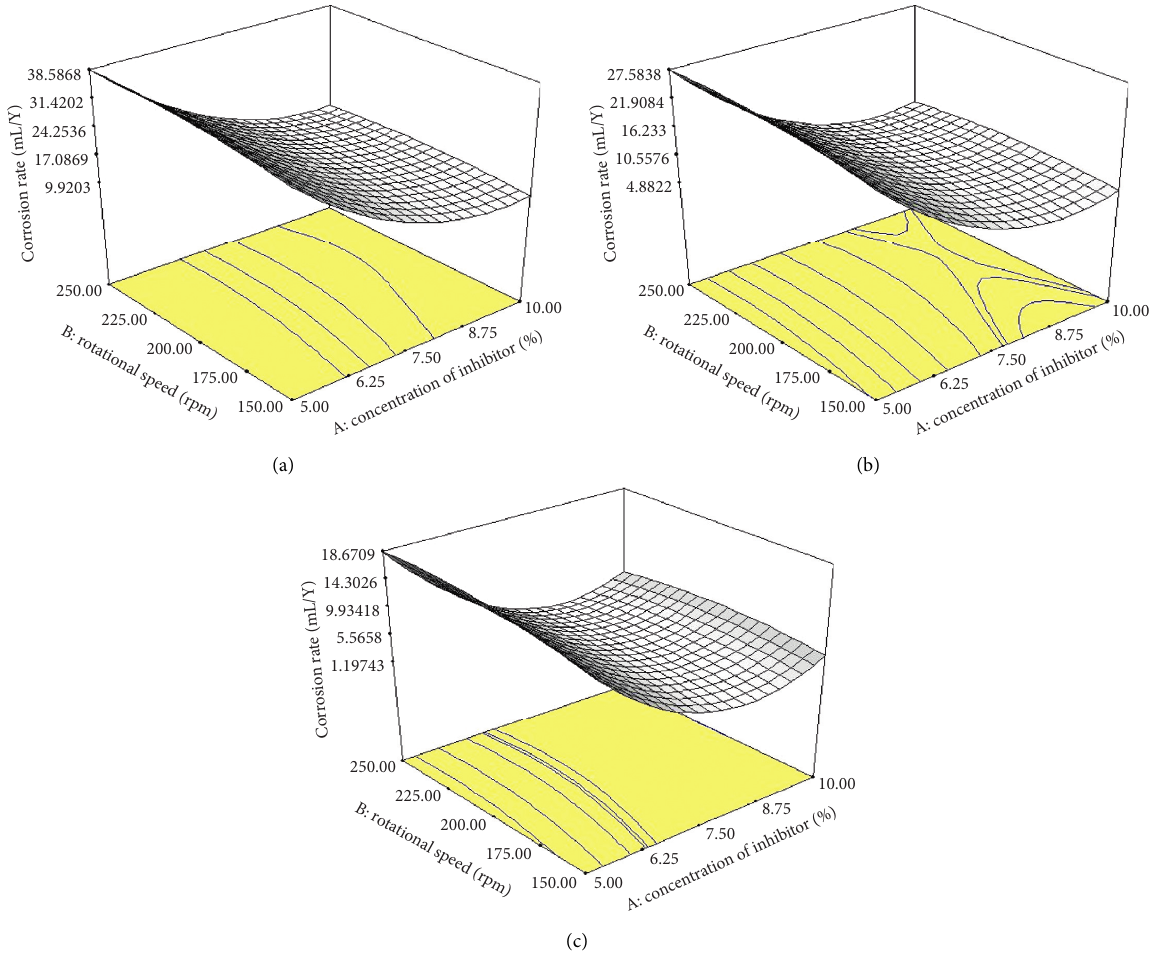
Figure 9: 3D plot of corrosion rate as a purpose of inhibitor load and rotation speed at temperatures (a) 75 ° C, (b) 50 ° C, and (c) 25 °